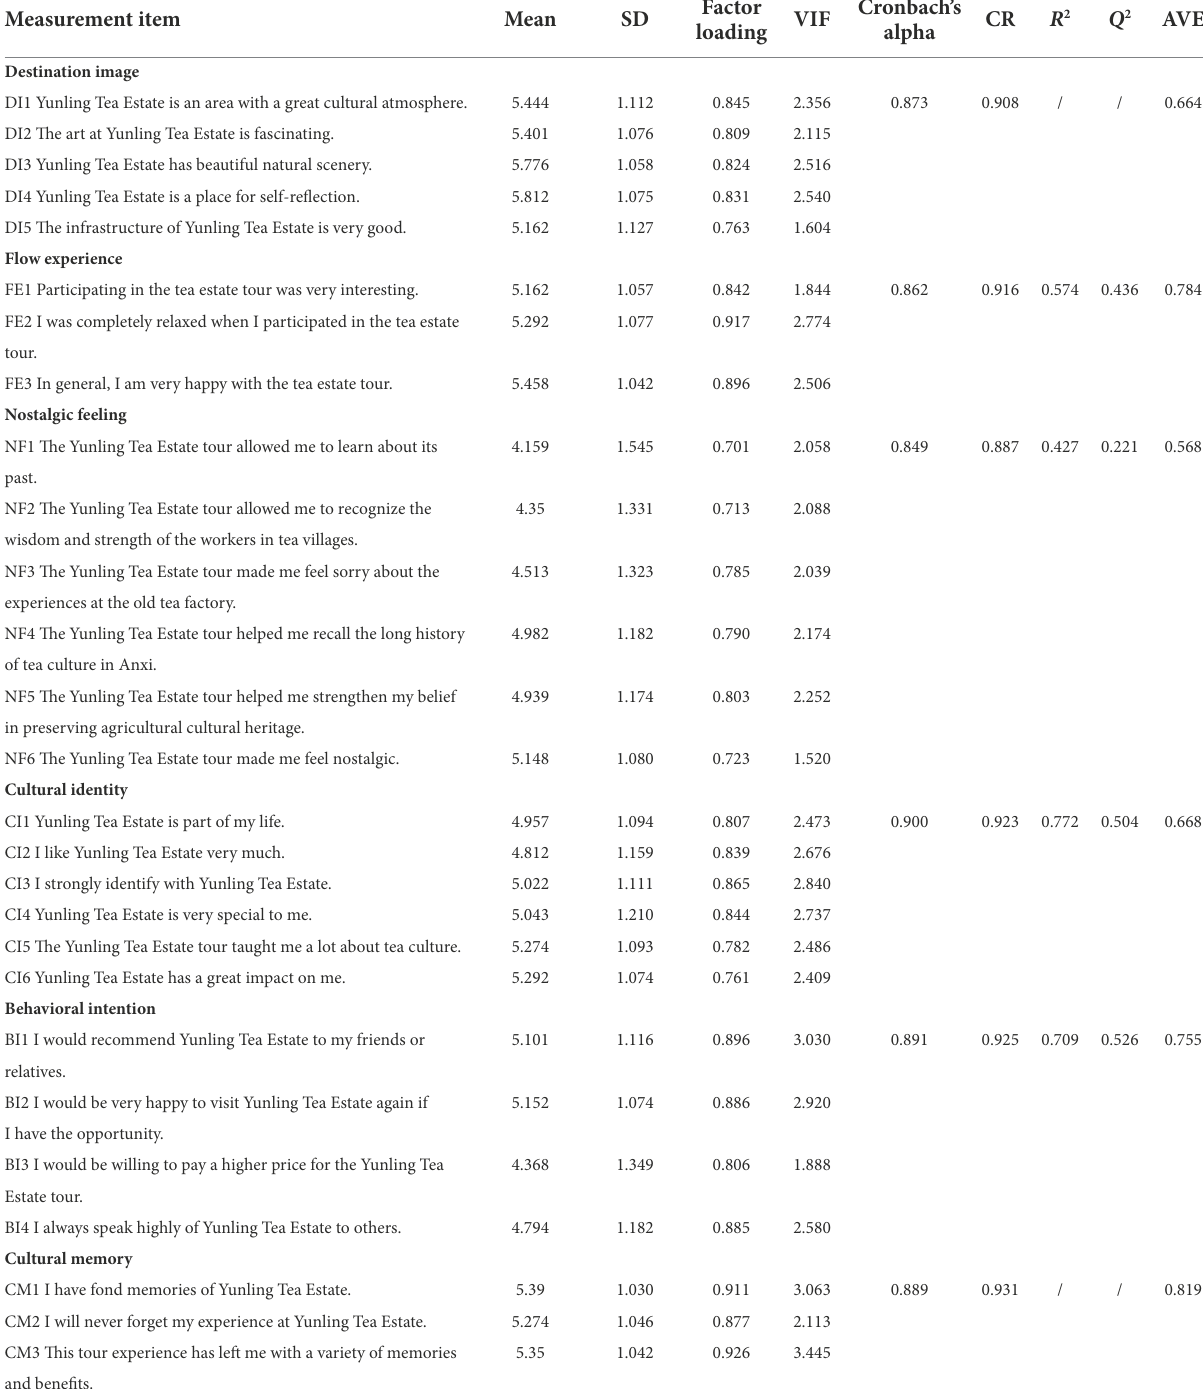
TABLE 1 Results of the confirmatory factor analysis ( N =